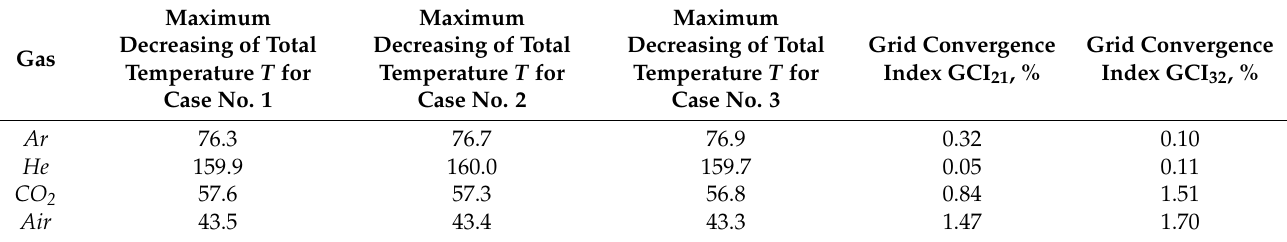
Figure 19. Contour of y + for SVT with ( a ) Ar ; ( b ) air ; ( c ) He ; and ( d ) CO 2 . Evaluation of the GCI parameter showed that the most significant discrepancy was observed for SVT with air and CO 2 (Table 10). Despite this, we can assume that its values are within the permissible range. Table 10. SVT efficiency with the same Reynolds number and without the inner body.